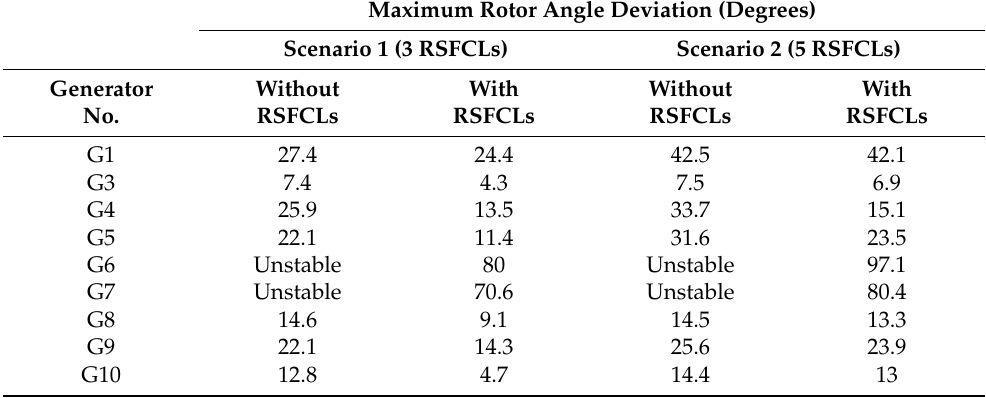
Table 5. Comparison of generators’ maximum rotor angle deviations in both scenarios for the considered short-circuit